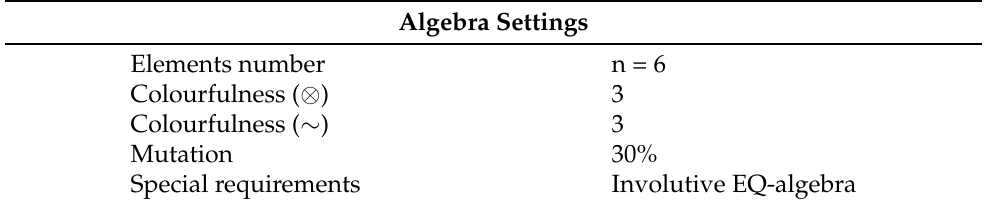
Table 6. EQCreator settings for involutive algebra.